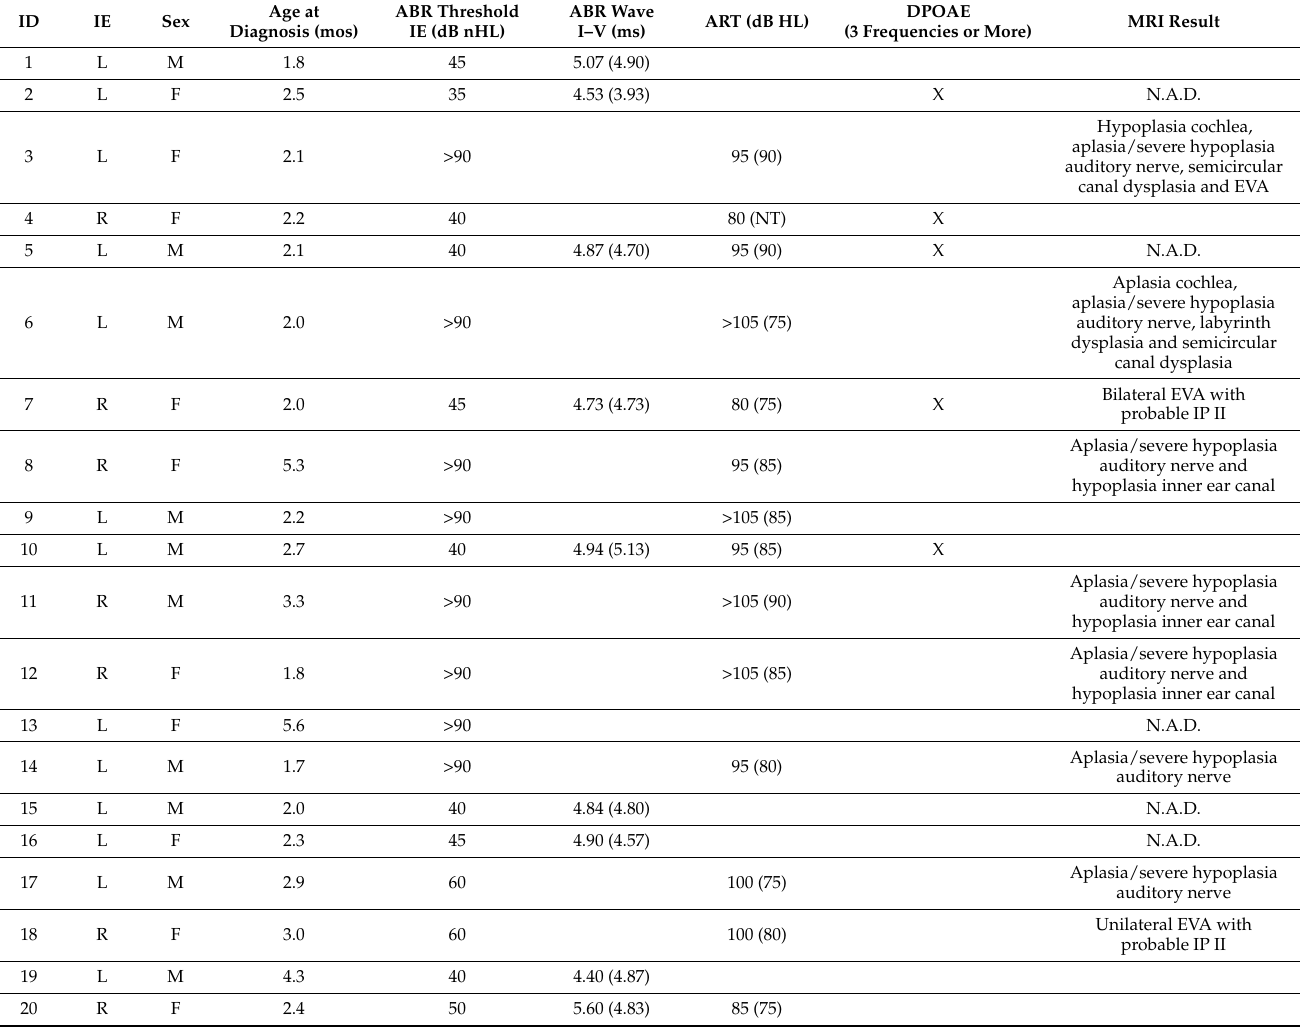
Table 1. Characteristics of the 20 infants’ impaired ears (IEs), with normal ear (NE) characteristics in parentheses when applicable (all NEs showed ABR thresholds of ≤ 20 dB nHL and are therefore not in